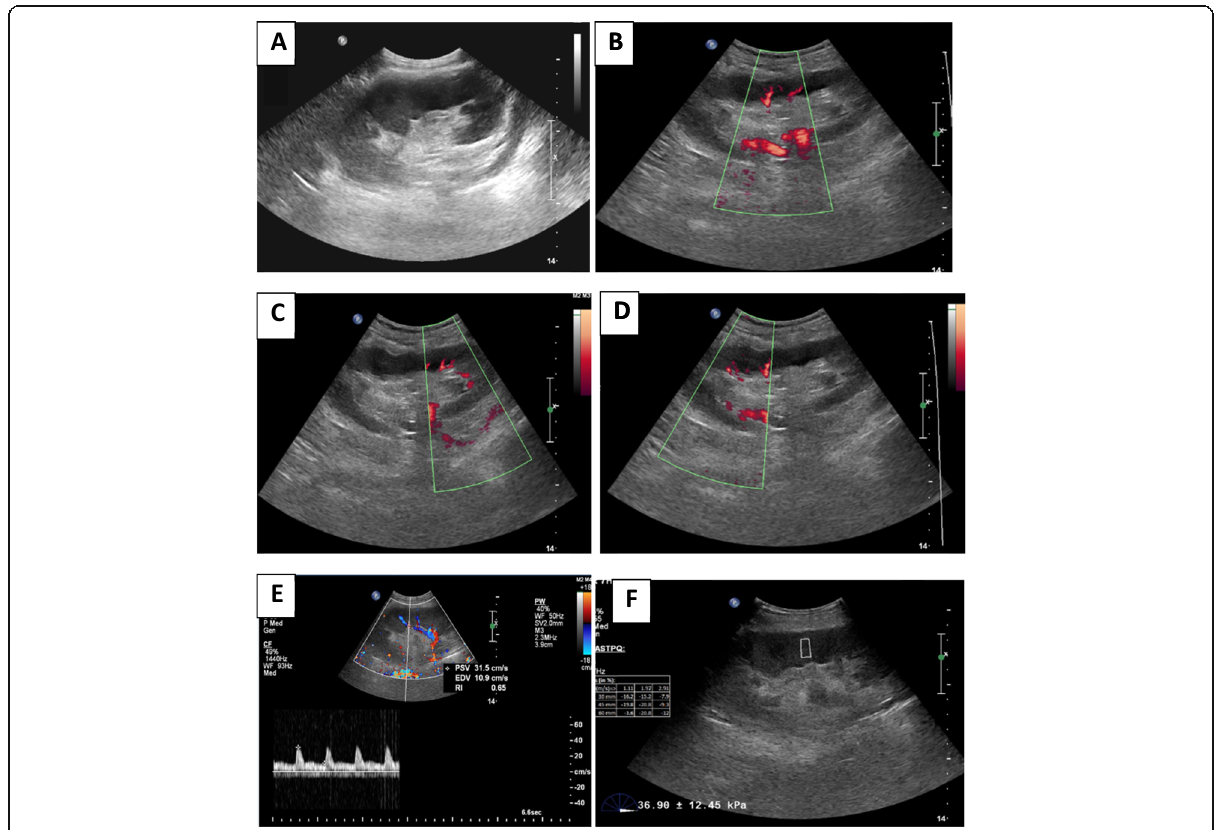
Fig. 4 A 37-year-old male patient who underwent renal transplantation in 2003, during follow-up in 26 March 2018, was presented with his creatinine level 1.8 mg/dl. a Graft the US showed average size graft , normal echo pattern, no back pressure changes, no peri-graft collection. b , c, and d , Power Doppler US showed reasonable cortical perfusion. e , Duplex Doppler US showed average RI = 0.65. f , Mean